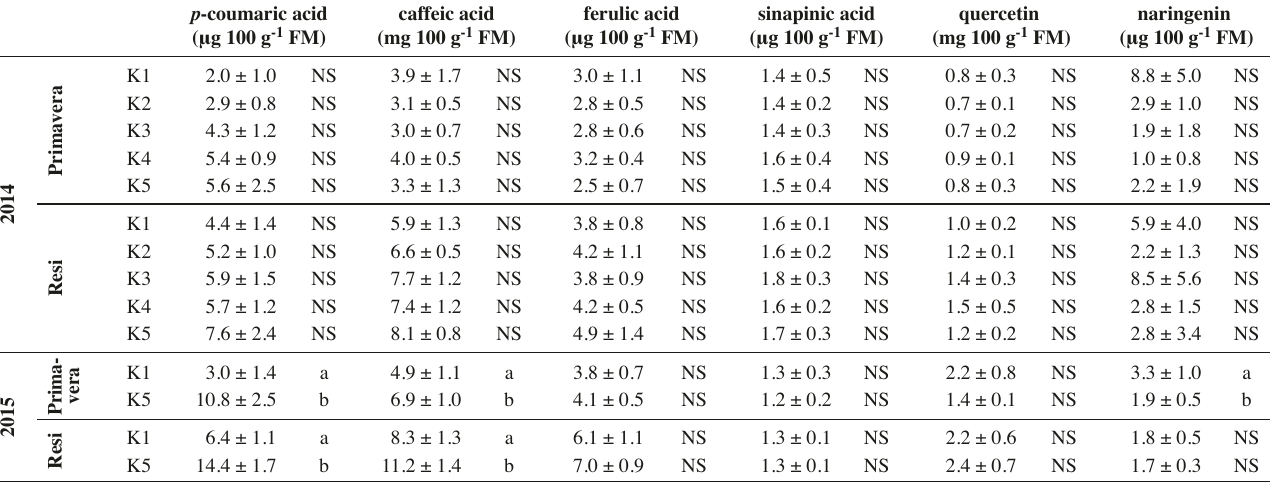
Tab. 2: Potassium (K) fertilization differentially affects the individual phenolic compounds of the cultivars. p -coumaric